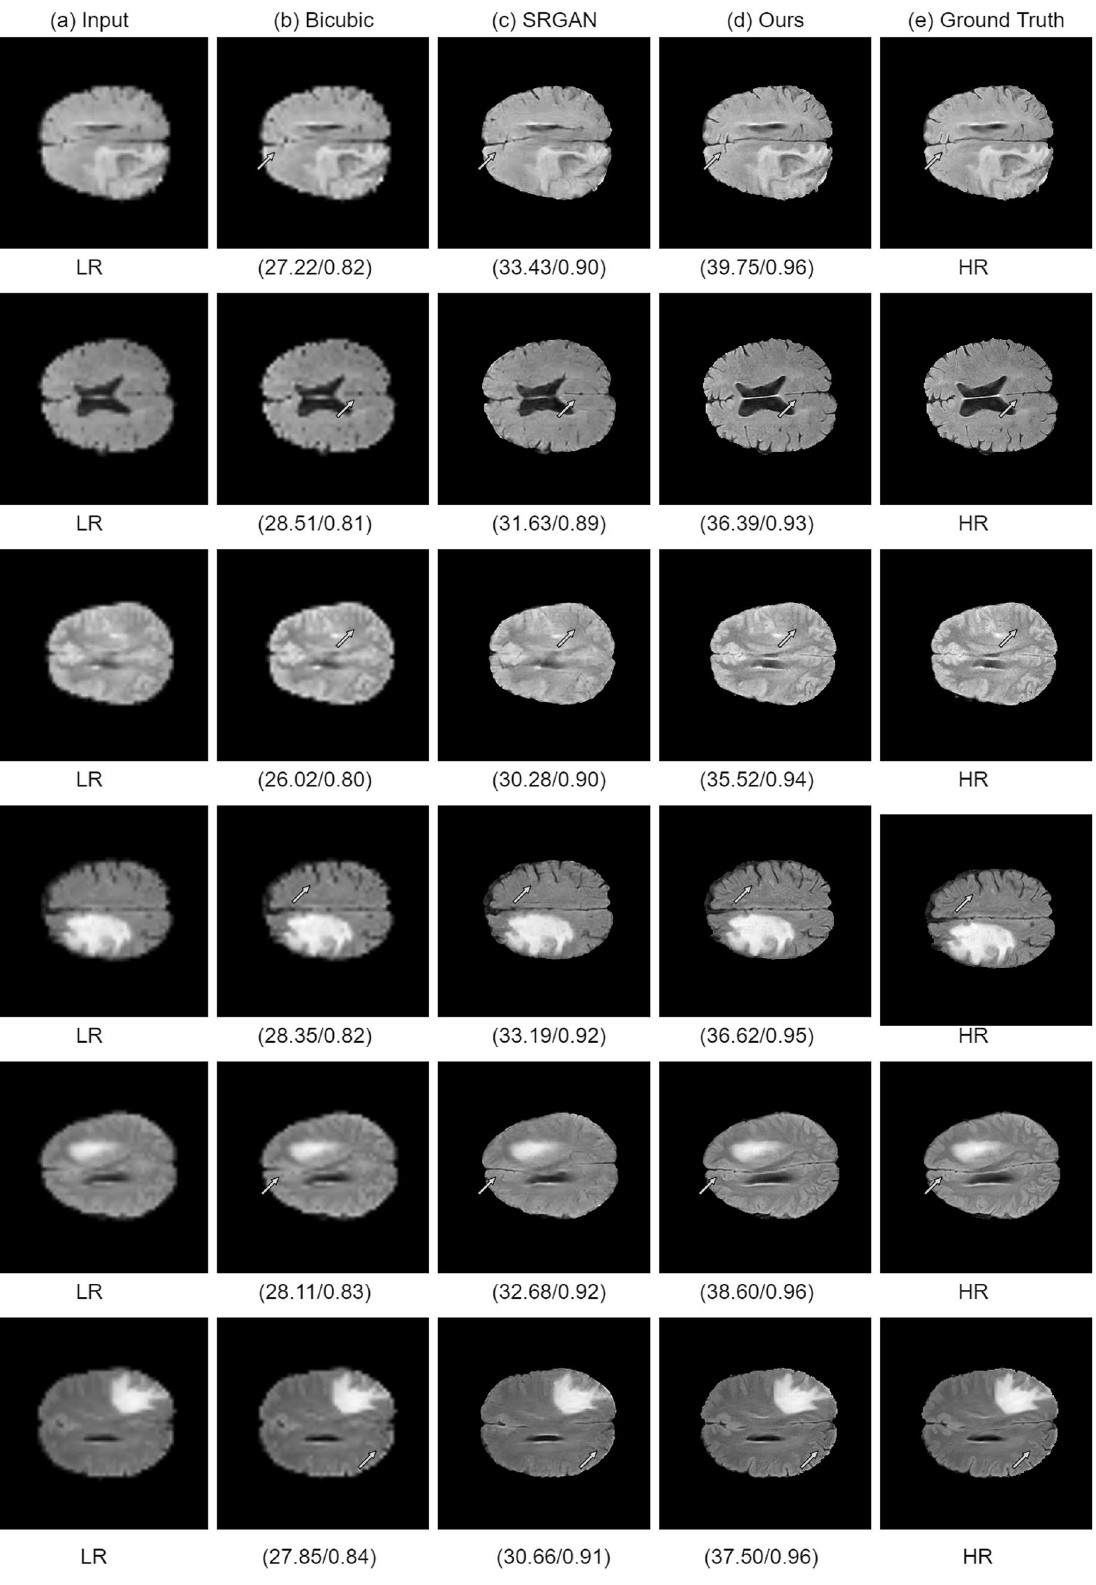
Figure 11. Results of super resolution for different images of BRaTS dataset. Column ( a ) shows the LR images (60 × 60, scaled for uniform display), column ( b ) shows results for Bicubic interpolation, column ( c ) shows results for SRGAN 31 , column ( d ) shows the results for the proposed architecture, column ( e ) shows ground truth HR images ( 240 × 240 ). Each row illustrates result of a single image. The corresponding (SSIM/PSNR) scores is mentioned below each image. Green arrows illustrate the degradation or improvement caused by each algorithm with respect to the ground truth HR